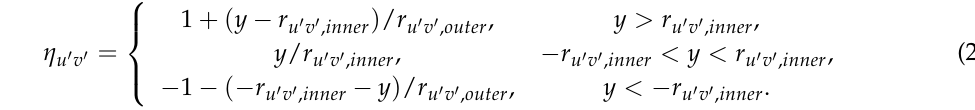
x / D 8 are ≤ ≤ u (cid:48) u (cid:48) is subtracted, which is the average (cid:68) (cid:69)